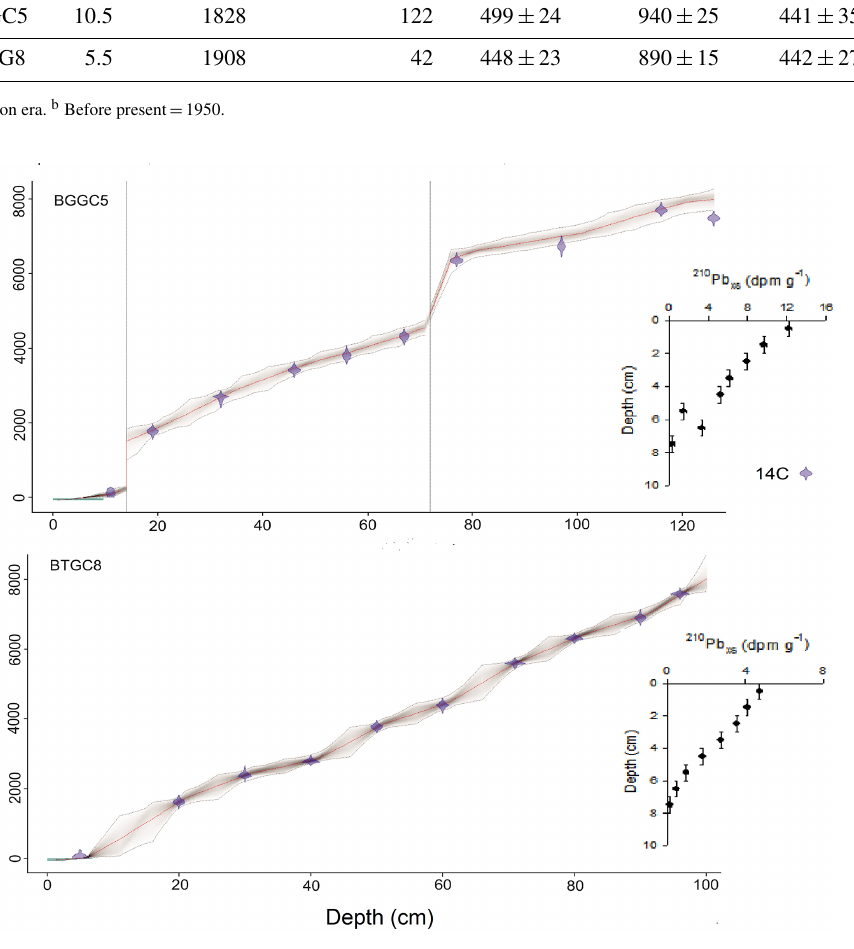
Figure 4. Age model based on 14 C-AMS and 210 Pb measurements. The timescale was obtained according to the Bacon age–depth-modeling open-source software (Blaauw and Christen, 2011) considering the Marine curve 13 C (Reimer et al.,